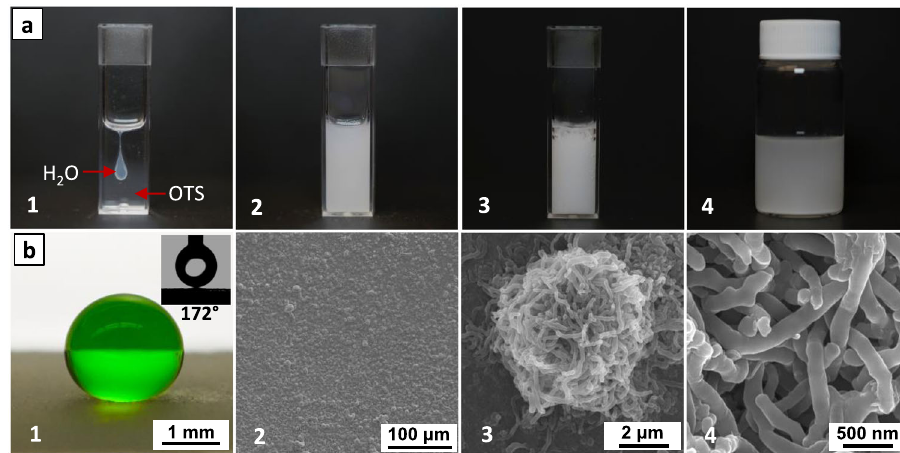
Fig. 1 Preparation and characterization of the superhydrophobic coating. a Preparation of the coating solution that can be applied on various solid substrates: (1) 2.0 mL of pure OTS added with 40 μ L of water; (2) upon mixing by vortex and sonication; (3) upon incubation for 2 h under ambient conditions; and (4) upon dilution with hexane (5% v/v OTS/hexane). b Morphological characterization of a microscope glass slide treated with the coating solution. The optical image on the left shows a water droplet (5.0 μ L) on the surface (inset shows the measured water contact angle). The three SEM images of different magni fi caitons show that the surface is covered with aggregated particles; these microparticles (2 to 20 μ m) are consist of entangled nano fi bers (width: 150 – 200 nm, length > 2 μ